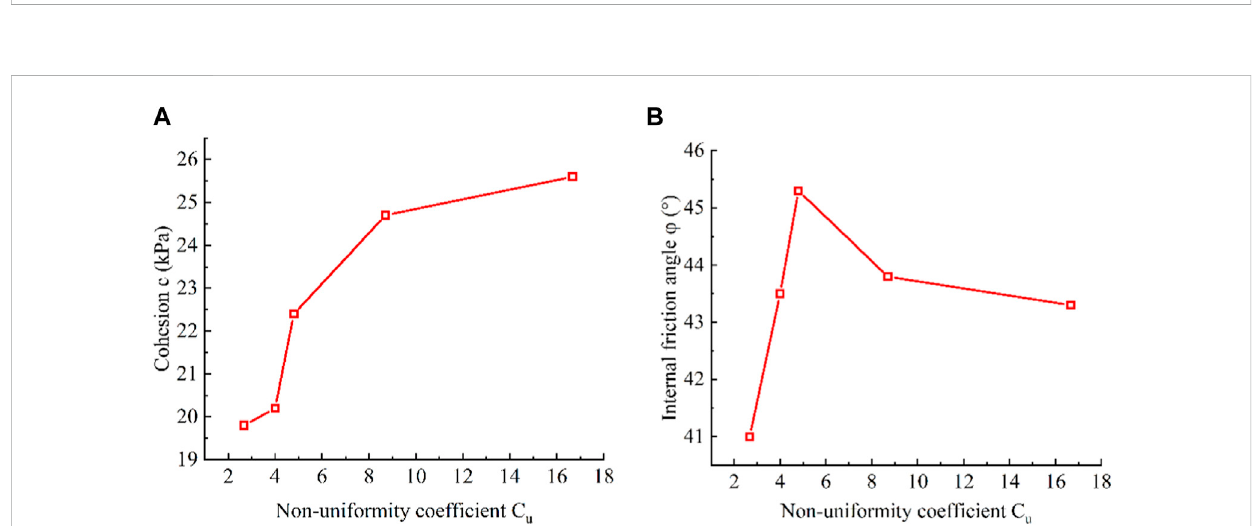
FIGURE 6 Relationship between Cu and cohesion and the internal friction angle. (A) Relationship between Cu and cohesion. (B) Relationship between Cu and the internal friction angle.